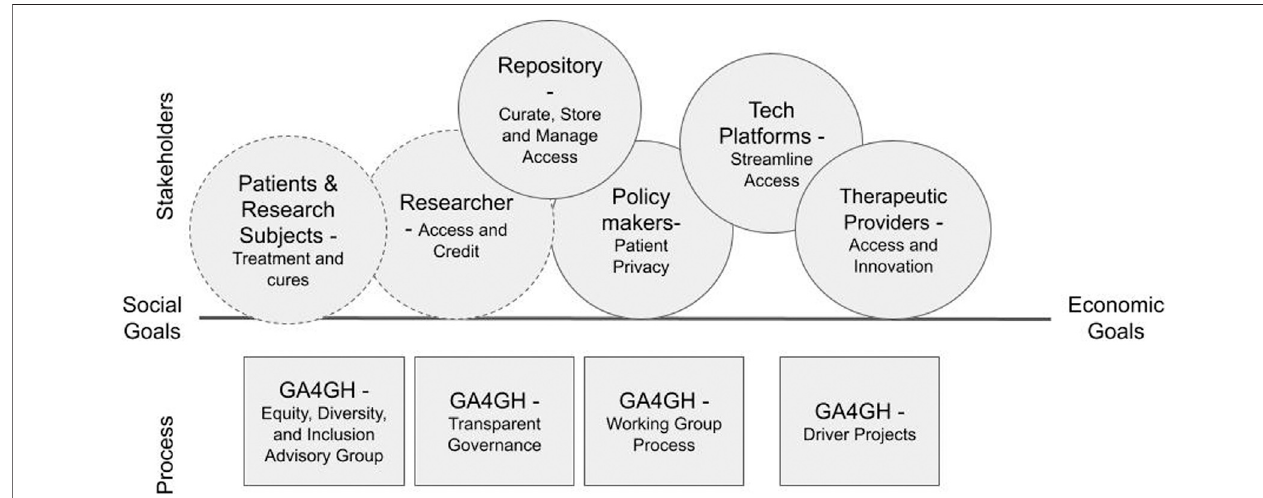
FIGURE 2 | GA4GH has been a multi stakeholder initiative from its founding. It has built a reputation for cross-stakeholder engagement through transparent inclusive processes and is able to attract a broad range of stakeholders to participate in standards development and implementation.